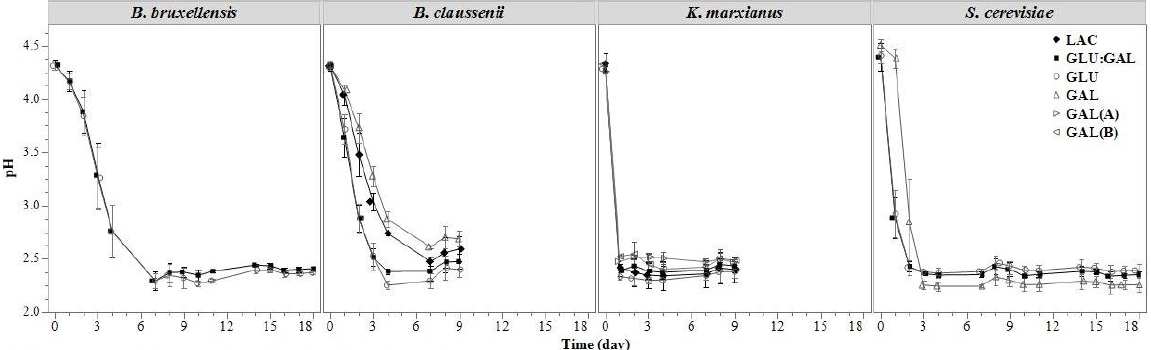
Figure 2. pH measurements of fermentates containing sugars associated with acid whey; fermentates were held at 25 °C and subjected to shaking at 185 rpm. Investigated sugars, supplemented at an initial concentration of 40 g/L: glucose (GLU); galactose (GAL); 1:1 ratio of glucose and galactose (GLU:GAL); and lactose (LAC). Error bars represent the standard deviations of three biological replicates, with the exception of K. marxianus , for which a fourth replicate was included. The results of K. marxianus in GAL have been subcategorized into treatments GAL(A) and GAL(B), based on the trends observed in this treatment’s density results.